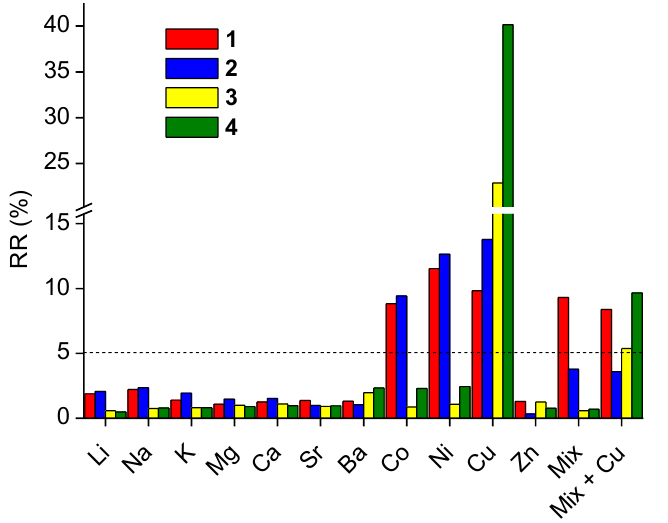
Figure 8. Interferences from several metal perchlorates, used in 10-fold excess, on the spectropho- tometric response towards lead(II) for 1 (2.54  10 − 5 M) at 605 nm, 2 (2.73  10 − 5 M) at 610 nm, 3 (2.08  10 − 5 M) at 610 nm and 4 (2.63  10 − 5 M) at 605 nm in acetonitrile (Mix — mixture of metal perchlorates without